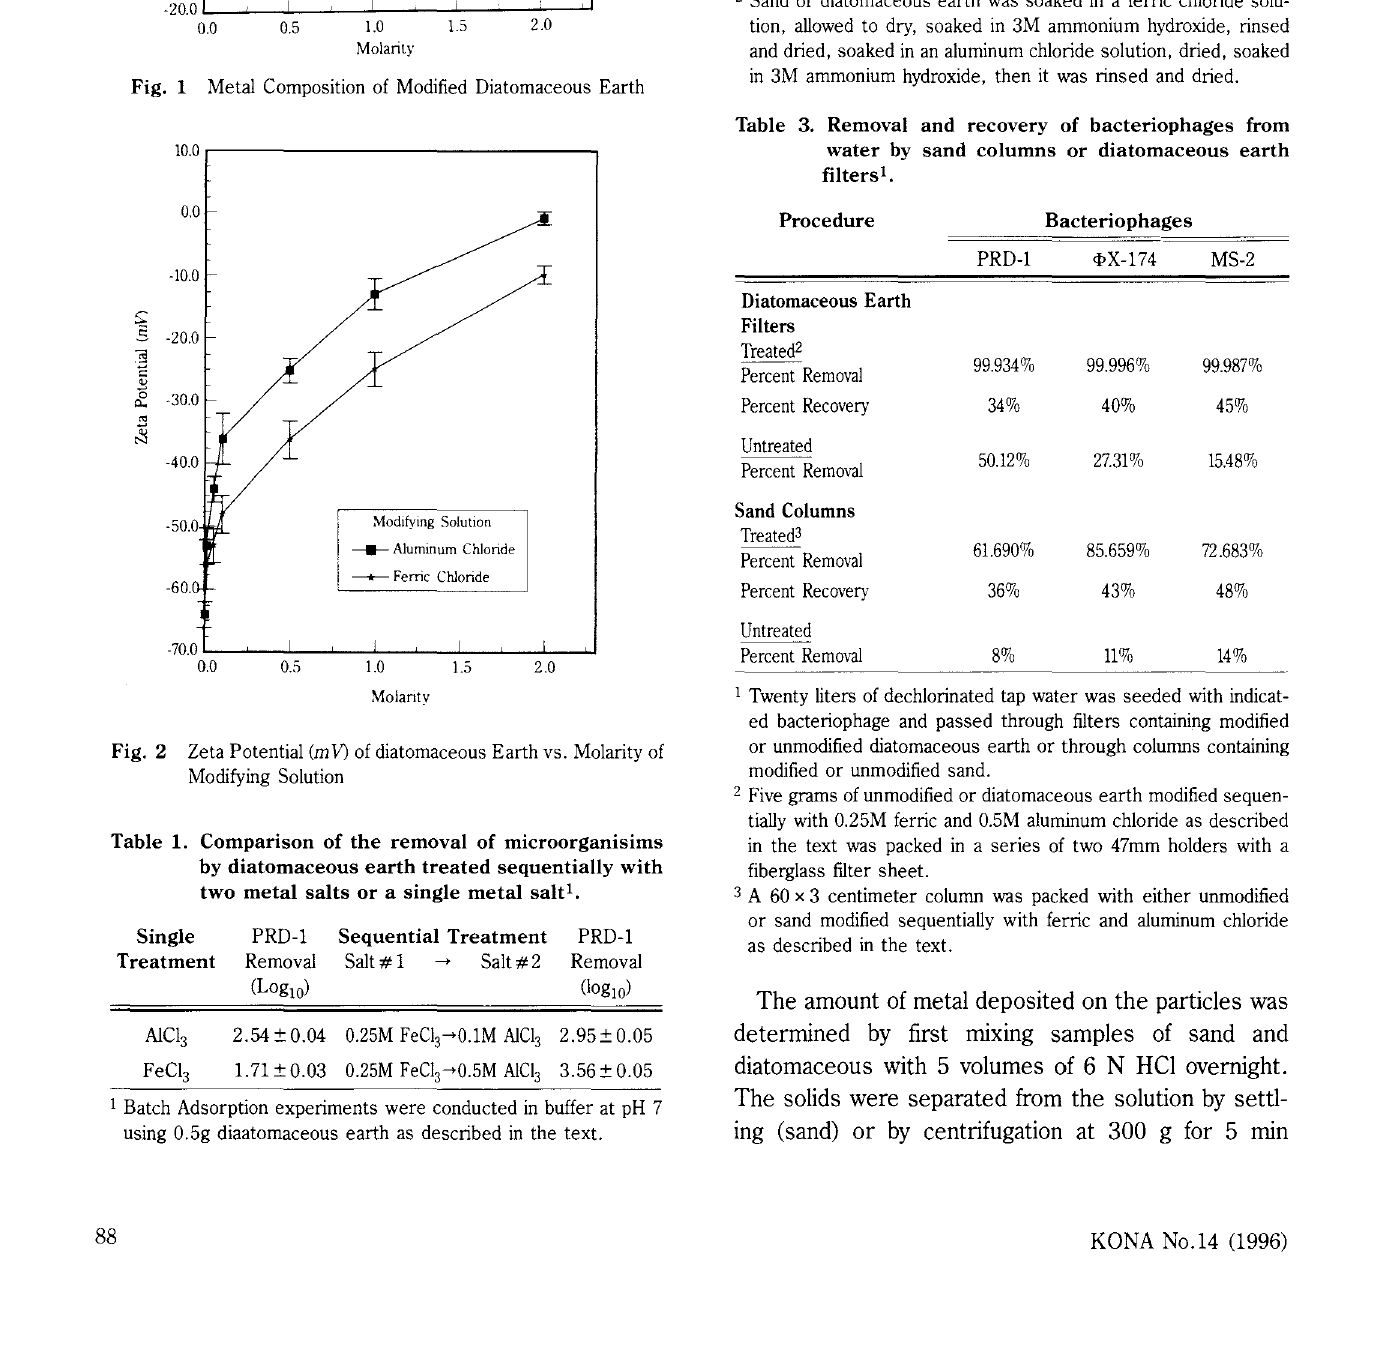
Fig. 1 Metal Composition of Modified Diatomaceous Earth